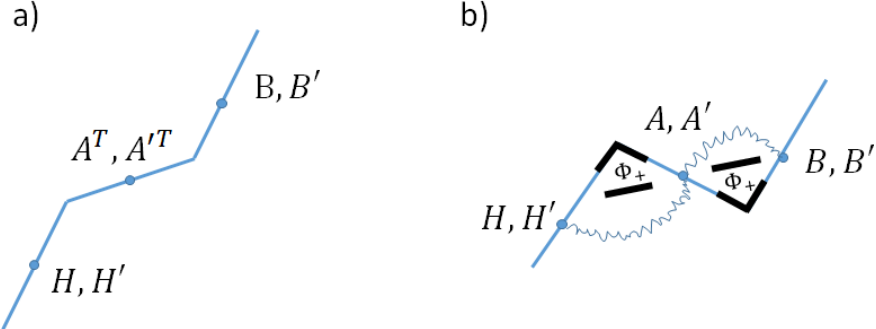
Figure 6 . Polyamorous violation of the CHSH inequality. Here, the violation is not of a spatial CHSH inequality, but a temporal CHSH